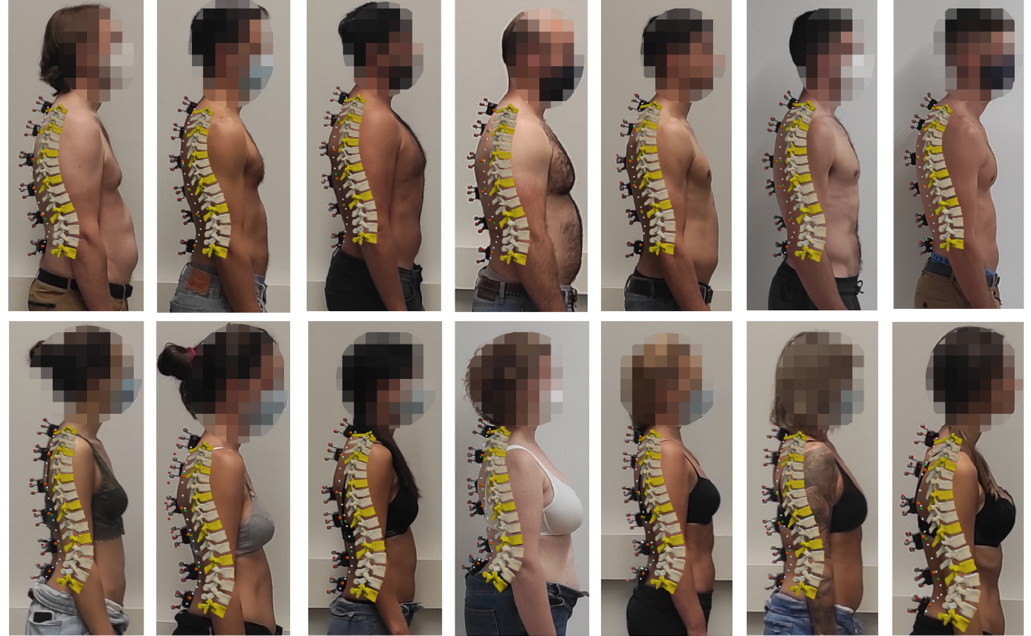
Figure 9. Lateral view of the fourteen 3D models obtained with TPM-IMU and six sensors.